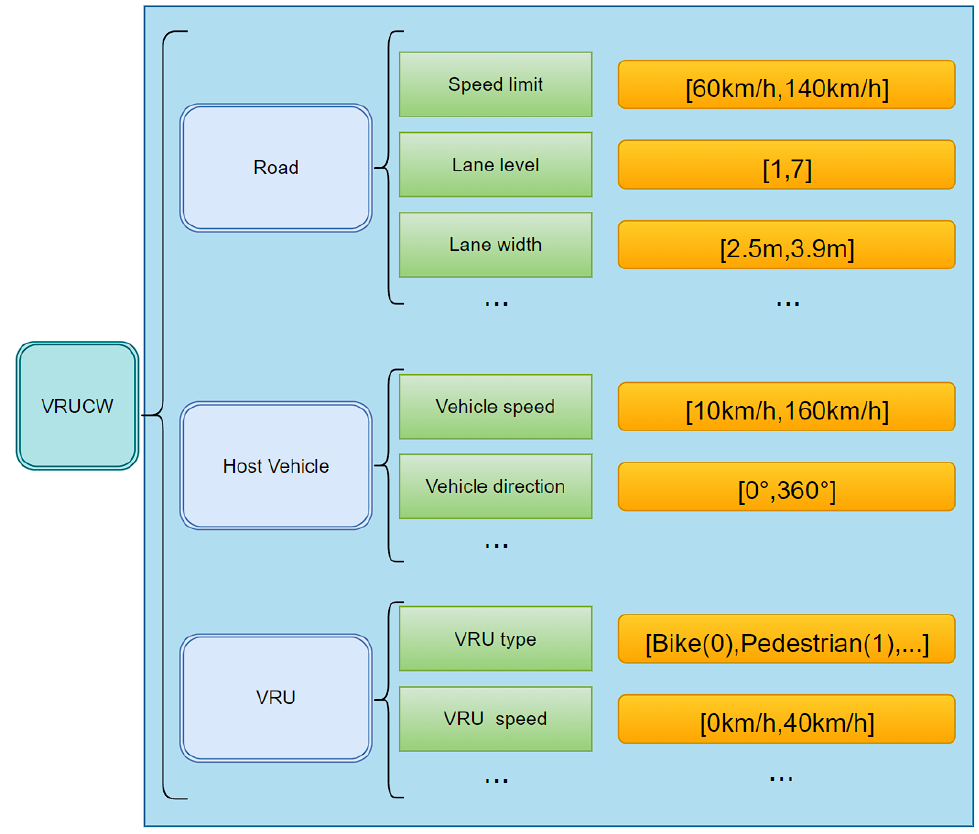
Figure 12. Logical scenarios for